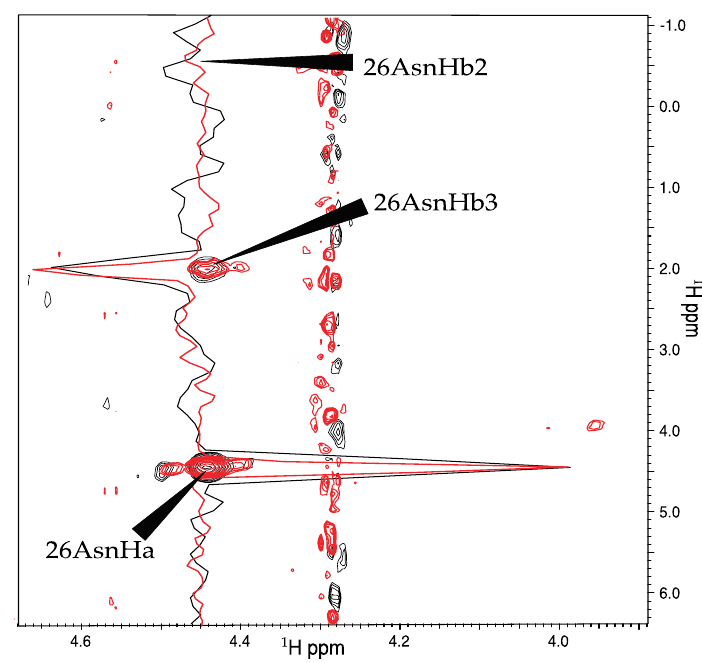
Figure 3. Comparison of spectra recorded with linear and NUS sampling. Shown are contour plots and slices through the peaks of Asn 26. The linearly sampled and the NUS spectra are colored black and red, respectively. The slices are scaled such that the diagonal peaks have equal intensity. Magnetochemistry 2018 , 4 , x FOR PEER REVIEW